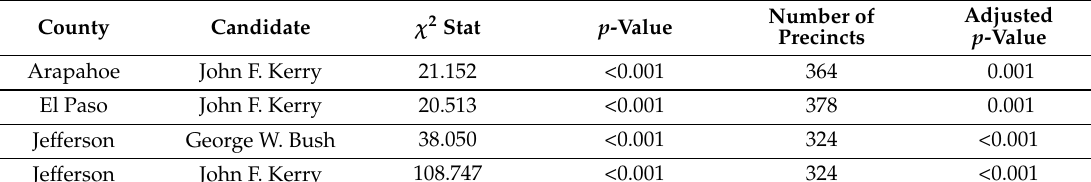
Table 6. First Digit Base 3 Benford’s Analysis on Selected Battleground and Non-Battleground States in the US 2004 Presidential